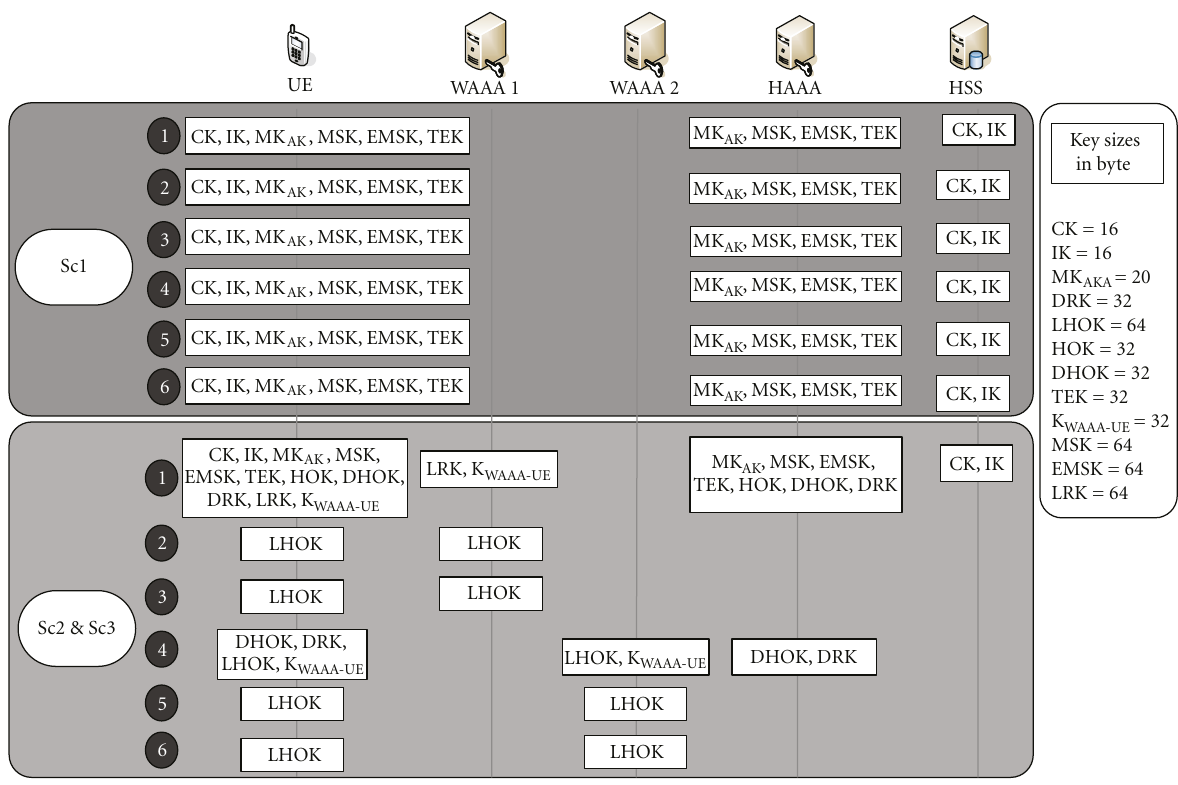
Figure 10: Keys generated by each node when n pre = 5.